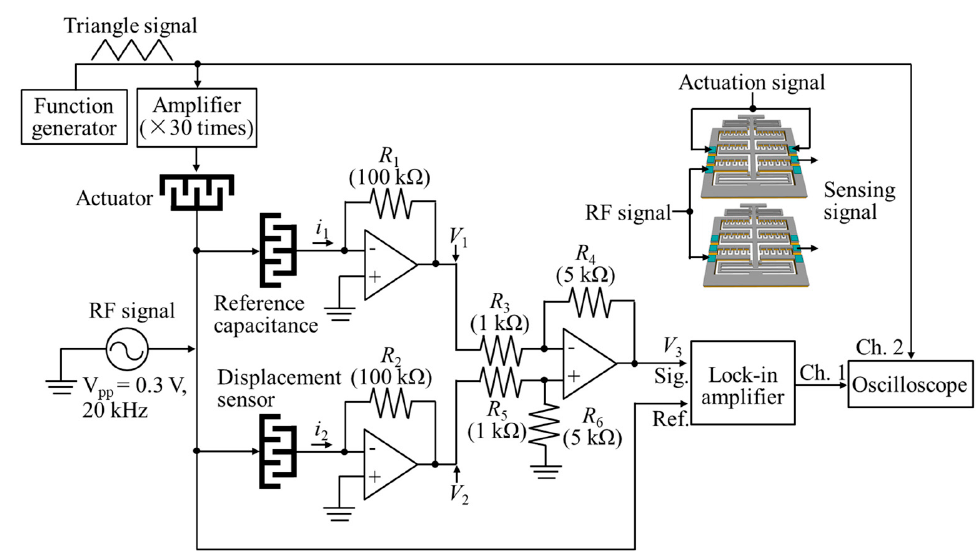
Figure 2. Displacement actuation and sensing circuit of the comb-drive actuator. (The inset shows the circuit interfaces connecting with the comb-drive actuator; the terms “signal”, “reference”, and “channel” are abbreviated as Sig., Ref., and Ch., respectively).